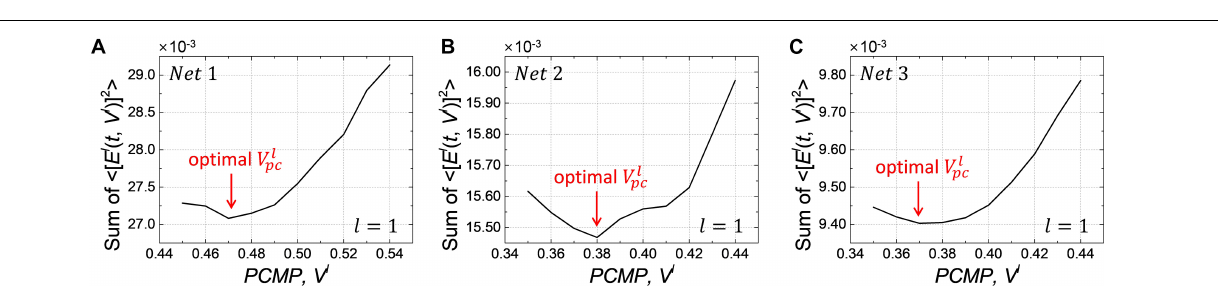
FIGURE 8 | Changes of the time sum of (cid:104)[ E l ( t , V l ) ] 2 (cid:105) in layer l = 1 when increasing the amount of PCMP , V l for (A) Net 1 , ( B) Net 2 , and (C) Net 3 . The optimization process is conducted from the input to the output layer sequentially, and it also needs to keep the optimized PCMP applied to the previous layers when performing the optimization for the subsequent